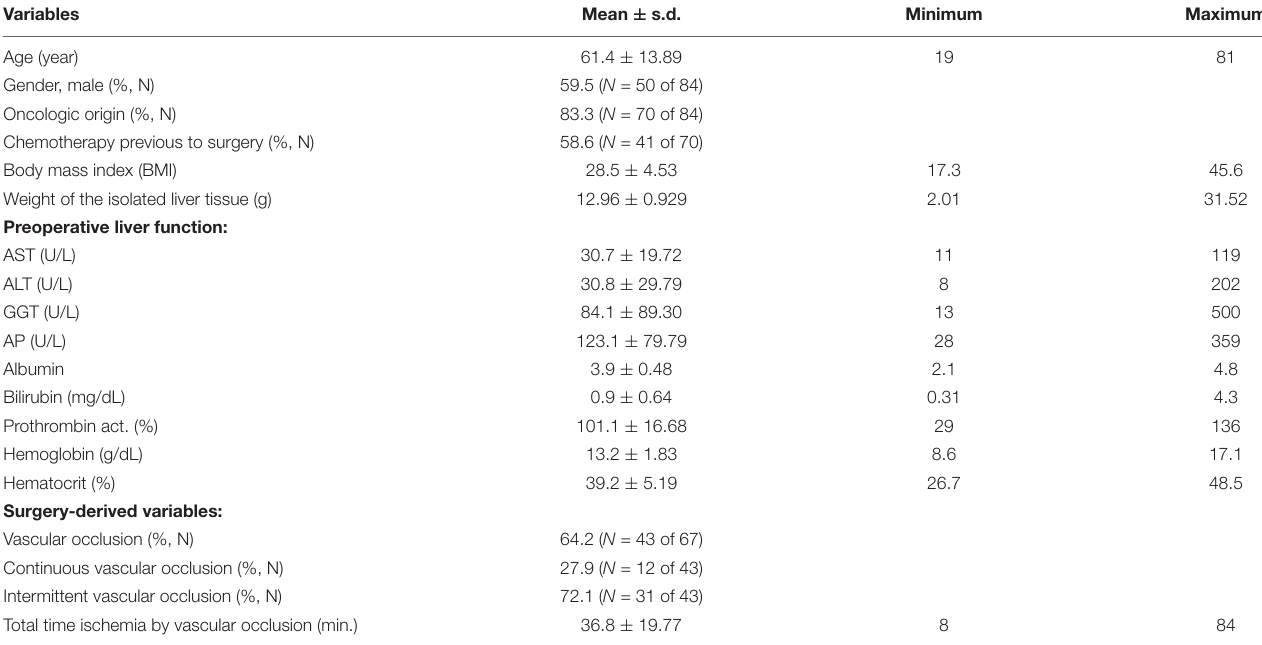
TABLE 1 | Patient characteristics prior to surgery and values of vascular occlusion maneuvers during liver resection.